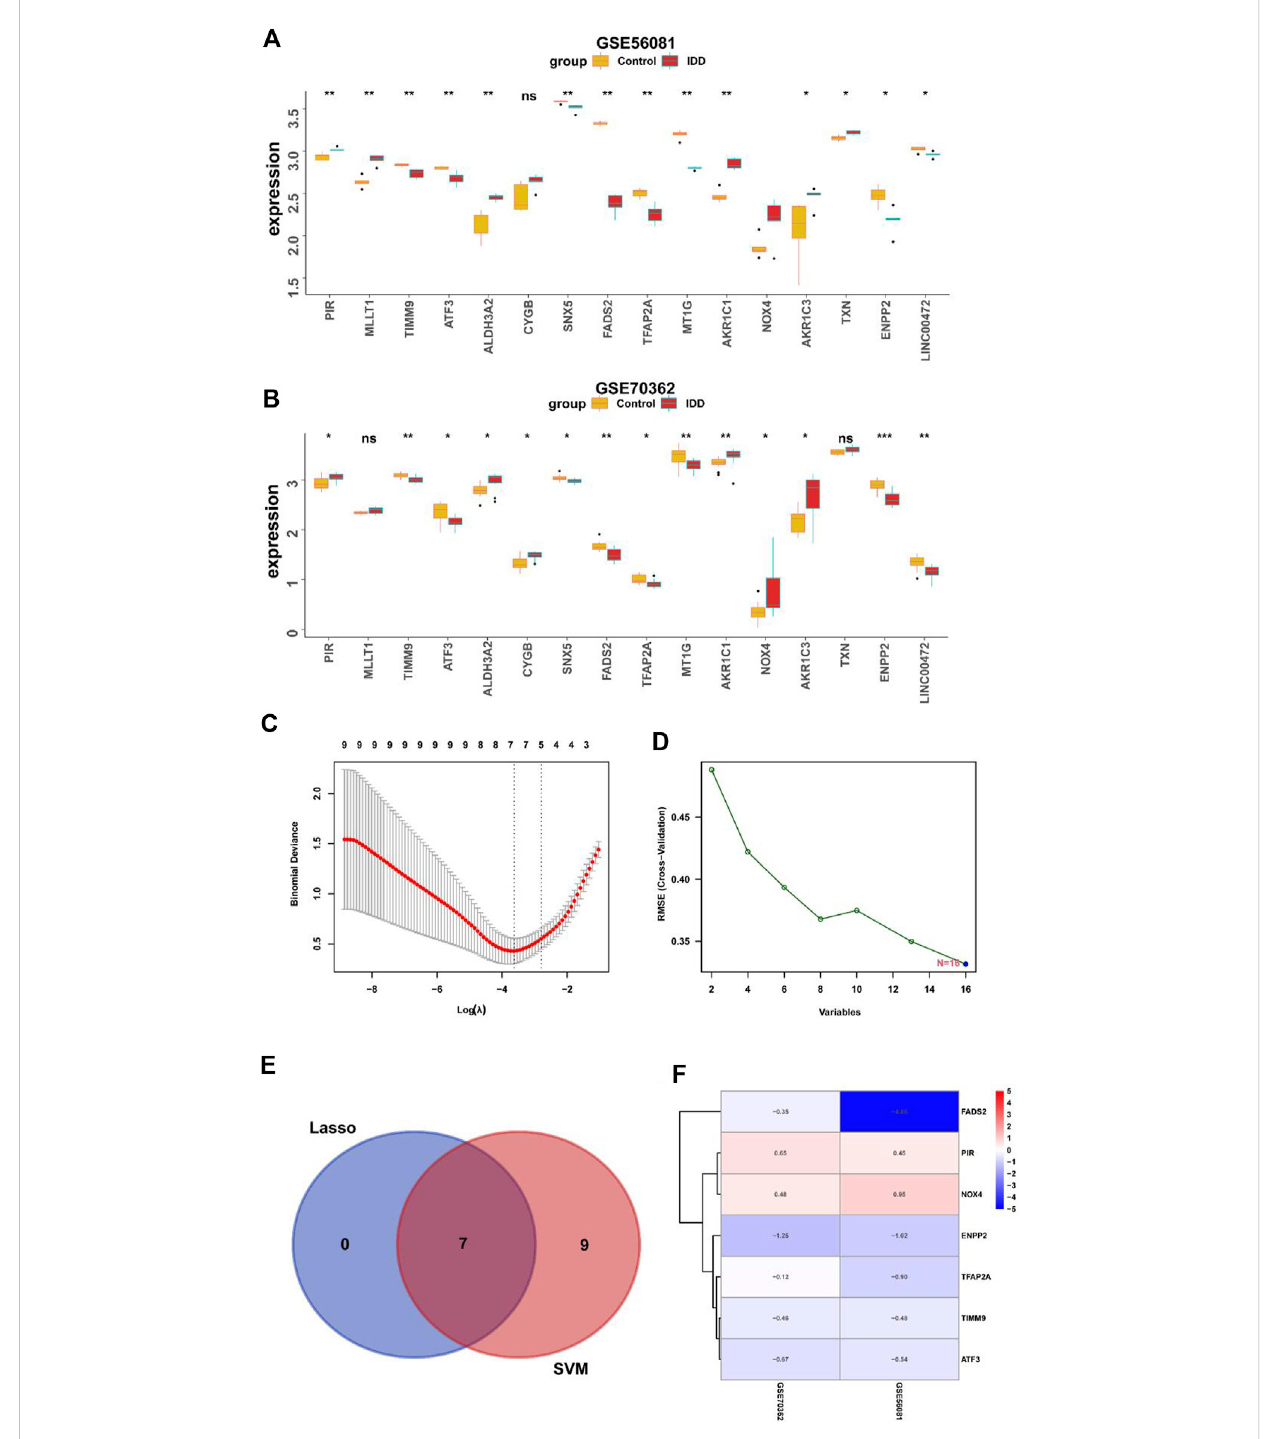
FIGURE 5 Screening key DEGs by machine learning. (A) Expression of ferroptosis-related DEGs in GSE56081 (*, p < 0.05; **, p < 0.01). (B) Expression of ferroptosis-related DEGs inGSE70362 (*, p < 0.05; **, p < 0.01). (C) Lasso algorithm to screencharacteristic genes. (D) Supportvector machine-recursive featureeliminationalgorithmtoscreencharacteristicgenes. (E) Venndiagramshowedtheoverlappedgenesobtained bytheLASSOalgorithmandSVM- RFE algorithm. (F) LogFC values of key DEGs in the difference analysis results of two